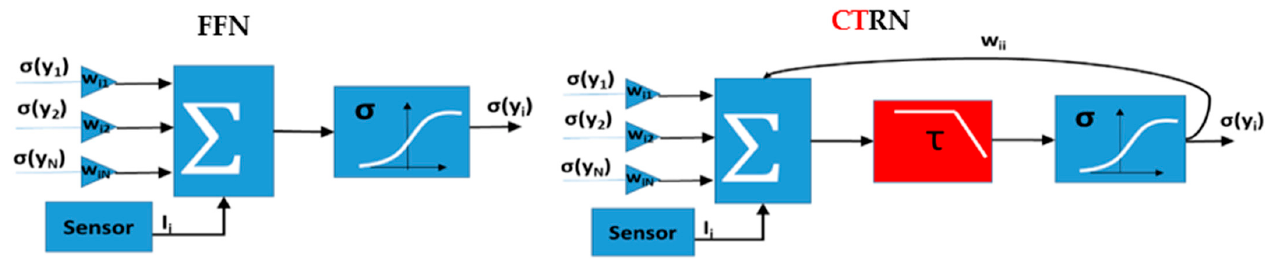
Figure 2. The differences between FFN and CT/RN. While CTRN and RN have internal memory through self-feedback, a CTRN approximates the response of a group of RNs by having a first-order differential equation.